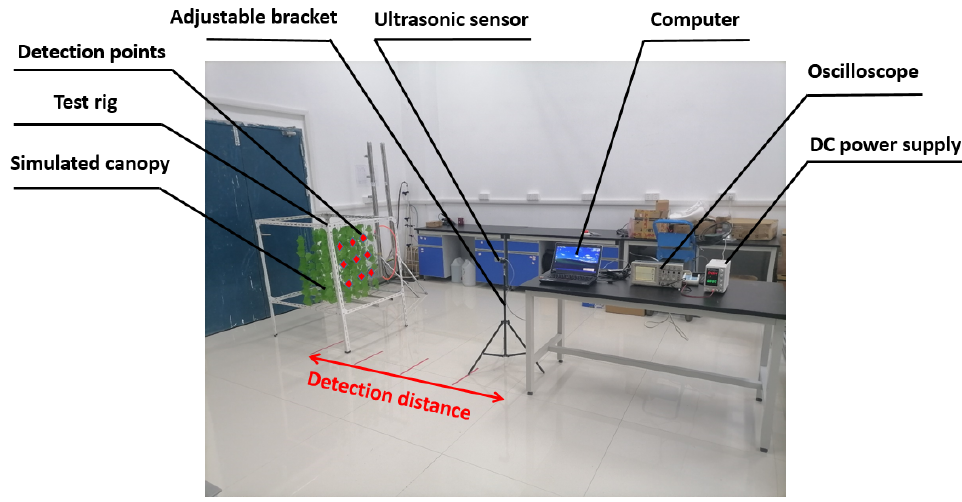
Figure 1. Simulated canopy thickness detection system.